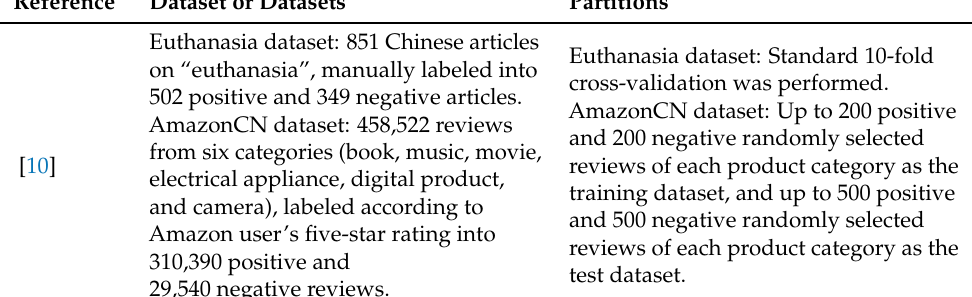
Table 3. Datasets used and partitions for training and testing of the detection approaches.